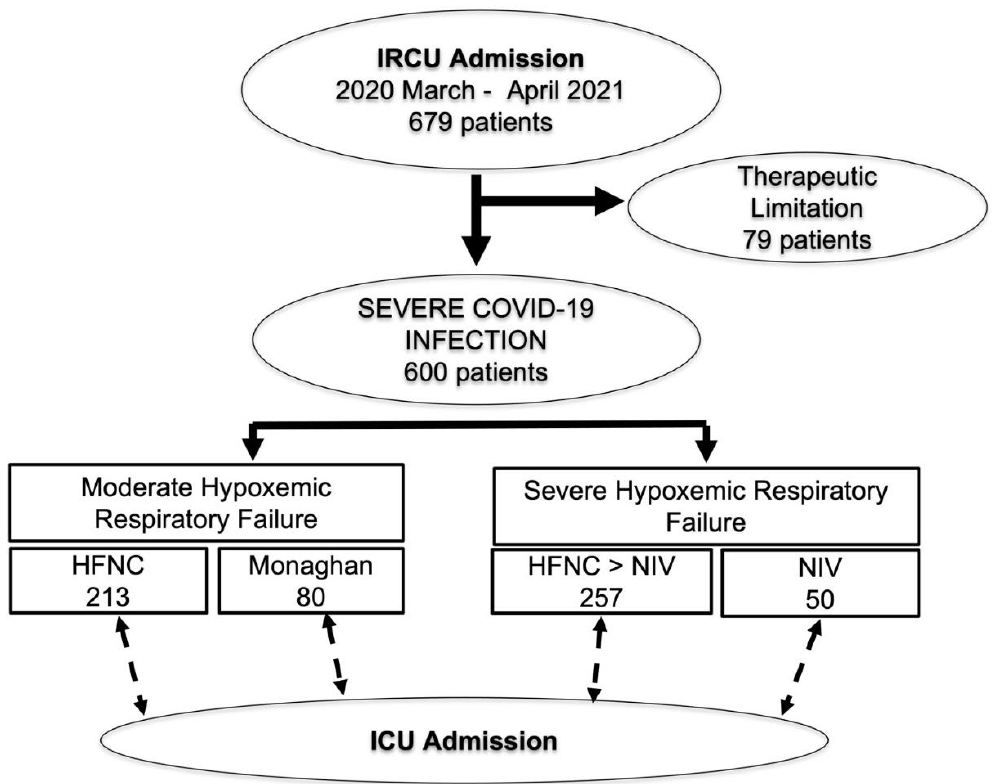
Figure 2. Patient flowchart. Flowchart of patients admitted to IRCU during the study period. IRCU, Intermediate respiratory care unit; HFNC, high flow nasal cannula; NIV, non-invasive ventilation; ICU, intensive care